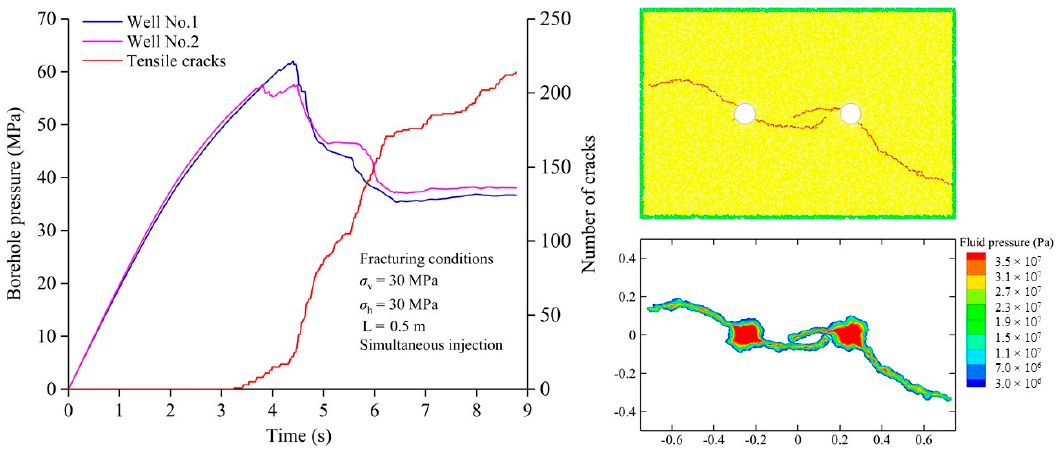
Figure 9. The borehole pressure histories, crack spatial distribution and corresponding fluid pressure field in the simultaneous fracturing under the hydrostatic pressure condition ( σ v = σ h = 30 MPa).